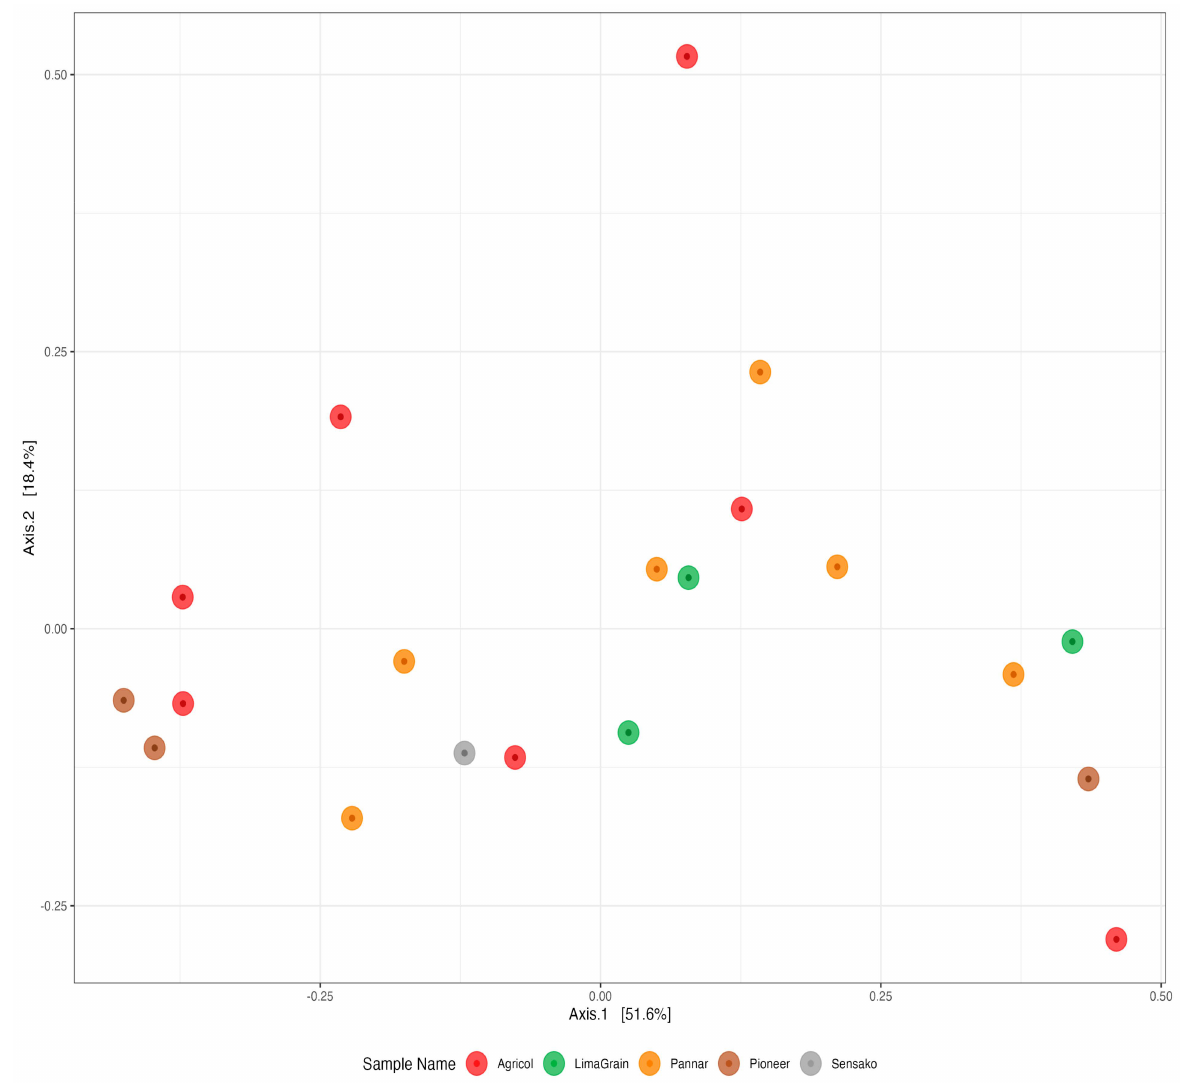
Figure 7. Principal co-ordinate analysis (PCoA) plot of beta diversity of fungi (based on Bray-Curtis dissimilarities) at the ASVs level of sunflower seeds. The PCoA data revealed that the first two PCoA components explained 18.4% and 51.6% of the variation,